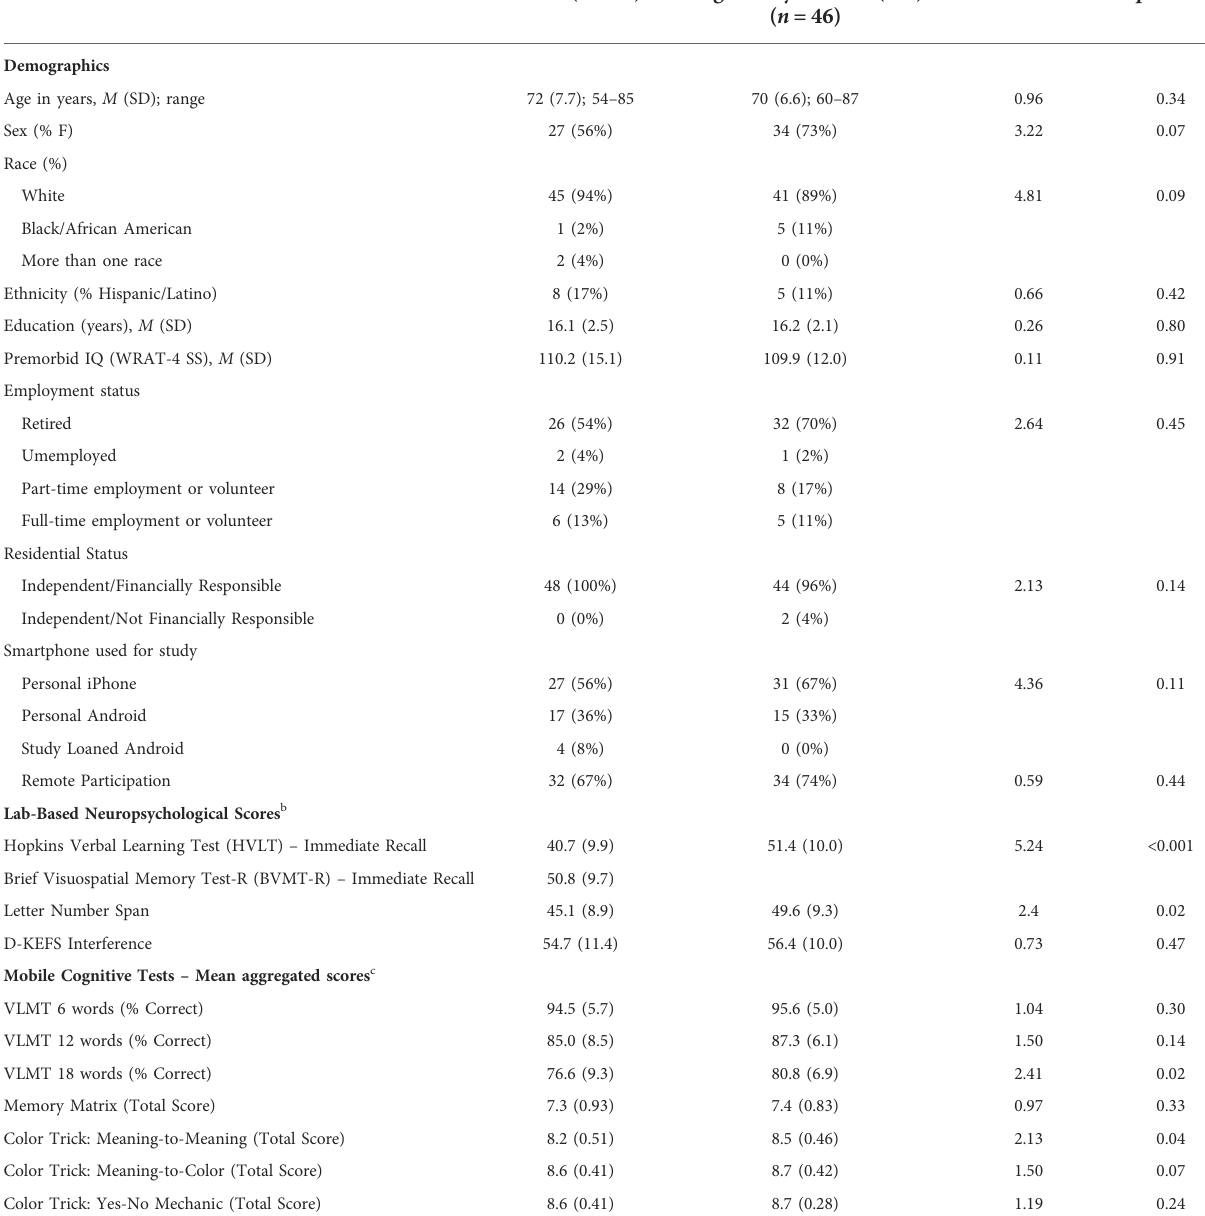
MCI ( n = 48) Cognitively Normal (CN) ( n =